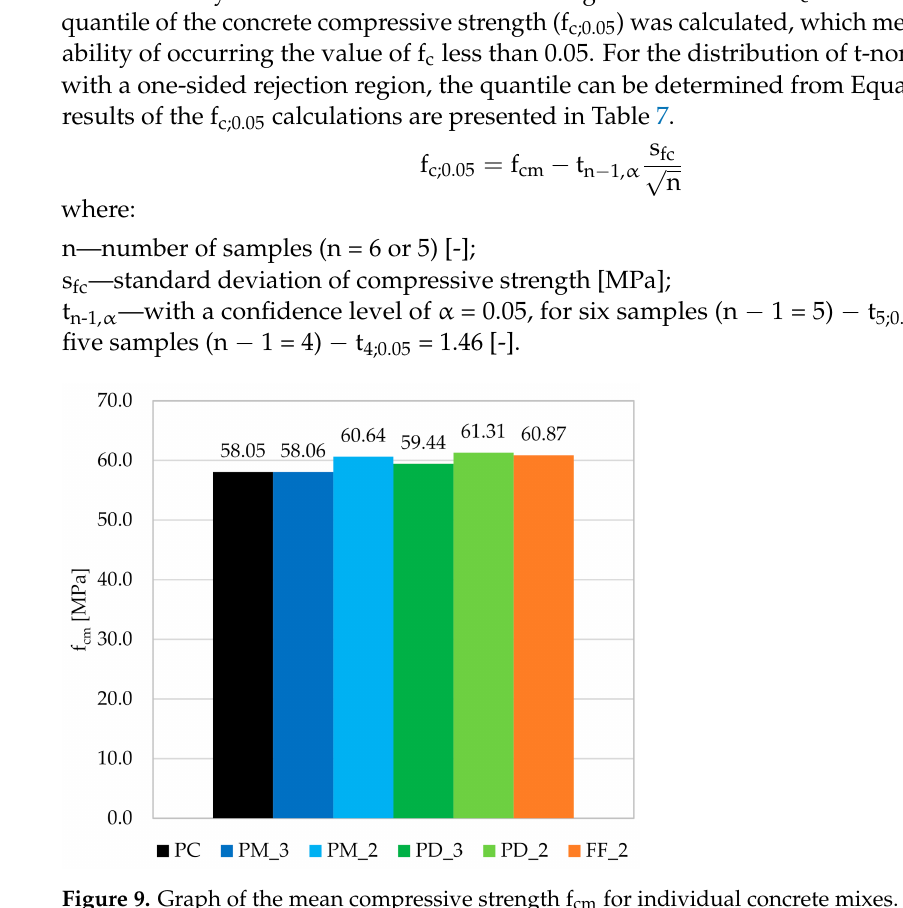
Figure 9. Graph of the mean compressive strength f cm for individual concrete